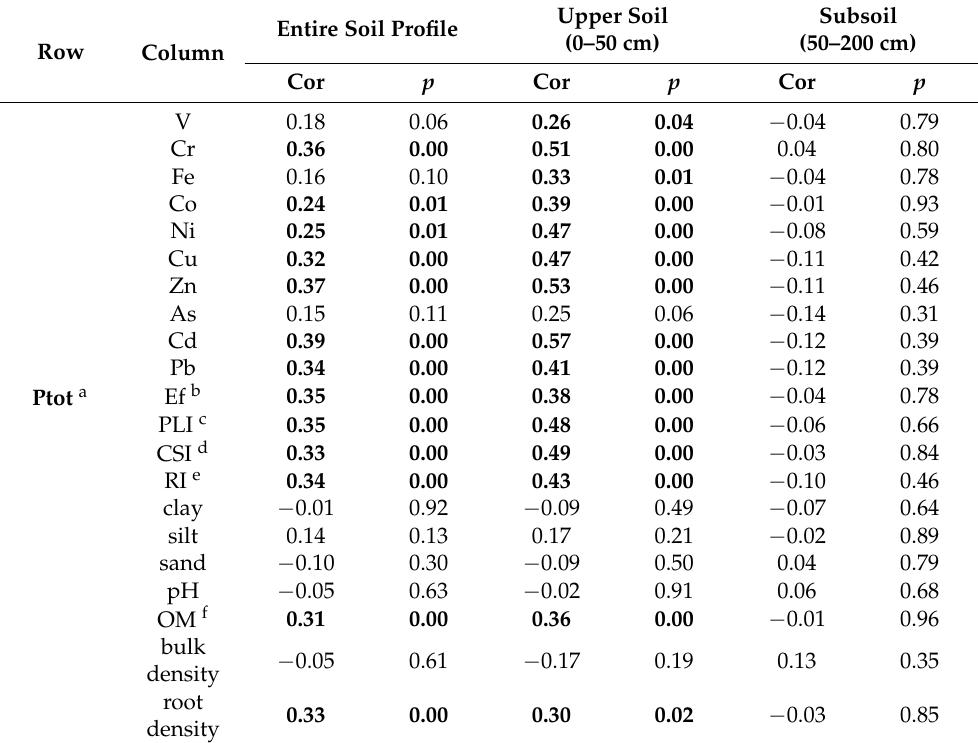
Table 1. Spearman correlation of total plastic concentration (Ptot) with metals, pollution indices, and soil properties for different soil depths.